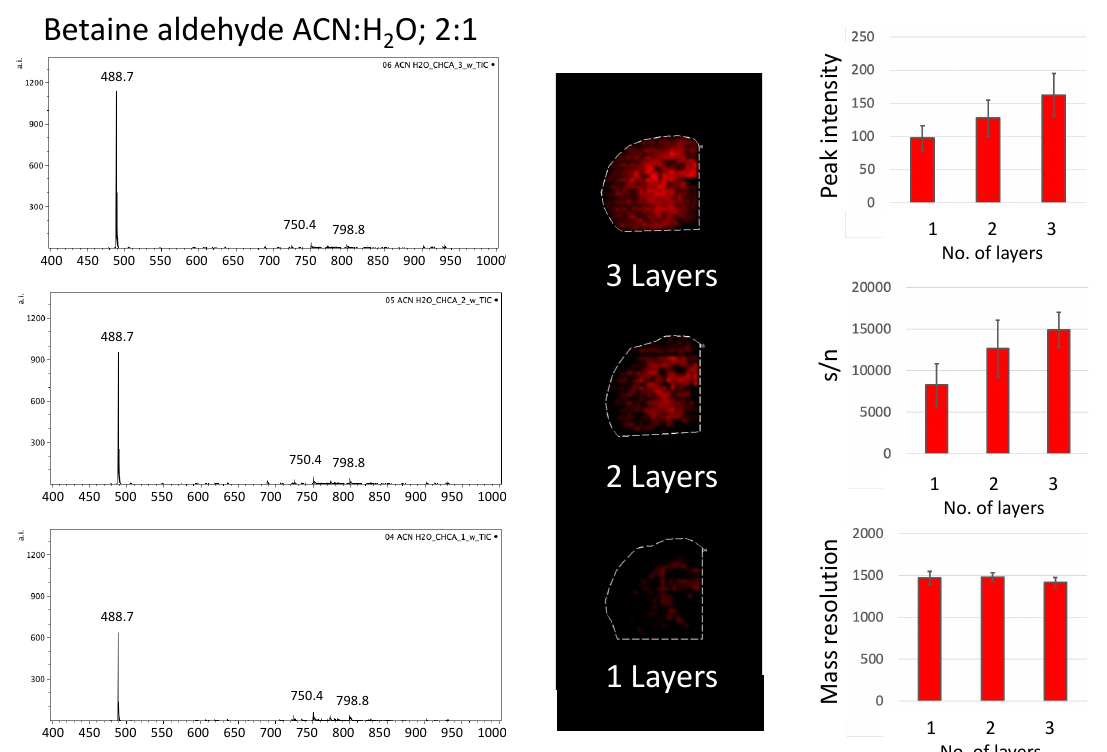
Figure 5. The influence of the number of layers of betaine aldehyde in acetonitrile with water solution, ACN:H 2 O = 2:1 ( v / v ), on obtained mass spectra.